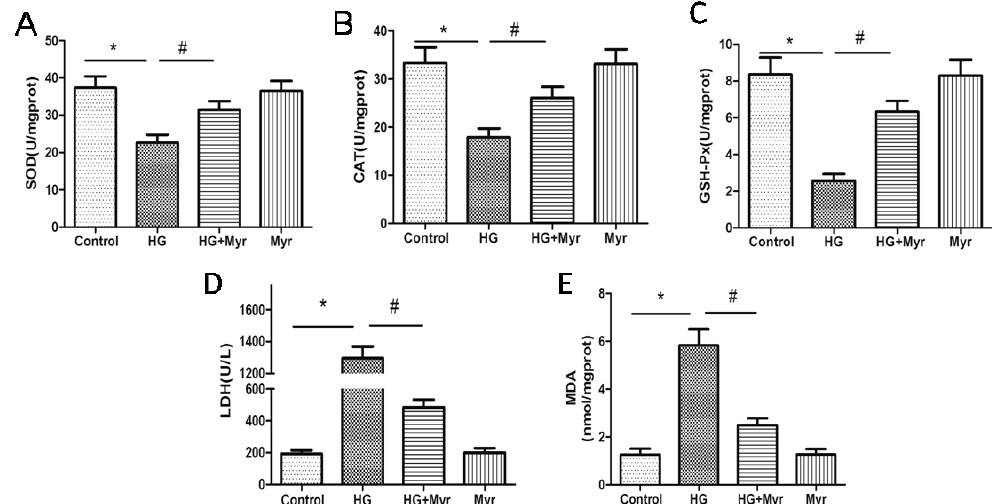
Figure 2. The effects of myricitrin on antioxidant enzyme activity in HG-induced H9c2 cells: SOD ( A ); CAT ( B ); GSH-Px ( C ); LDH ( D ); and MDA ( E ) activities were determined using the kits. Values are represented as the mean ± SD ( n = 9). The results were representative of three independent experiments. * p < 0.01 vs. control; # p < 0.01 vs. HG.